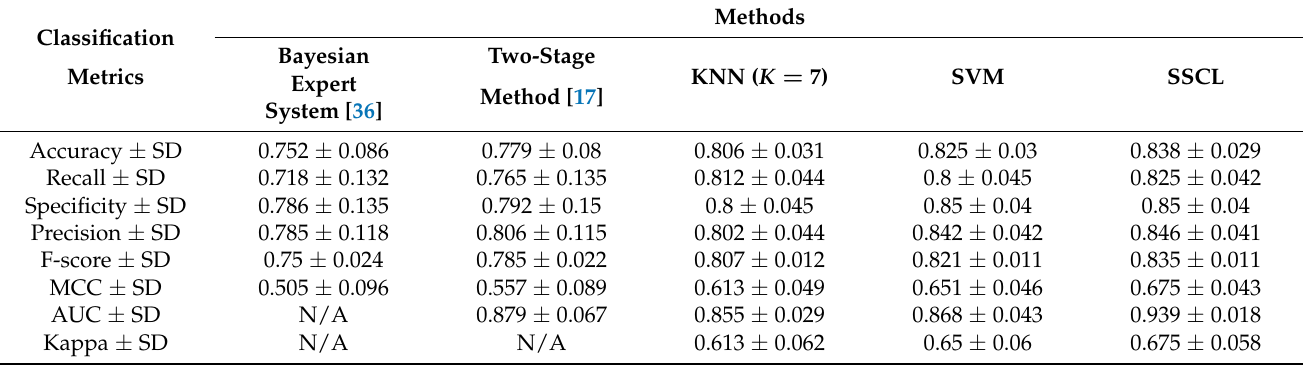
Table 4. Classification results of vocal patterns of HC subjects and PD patients. N/A: Not